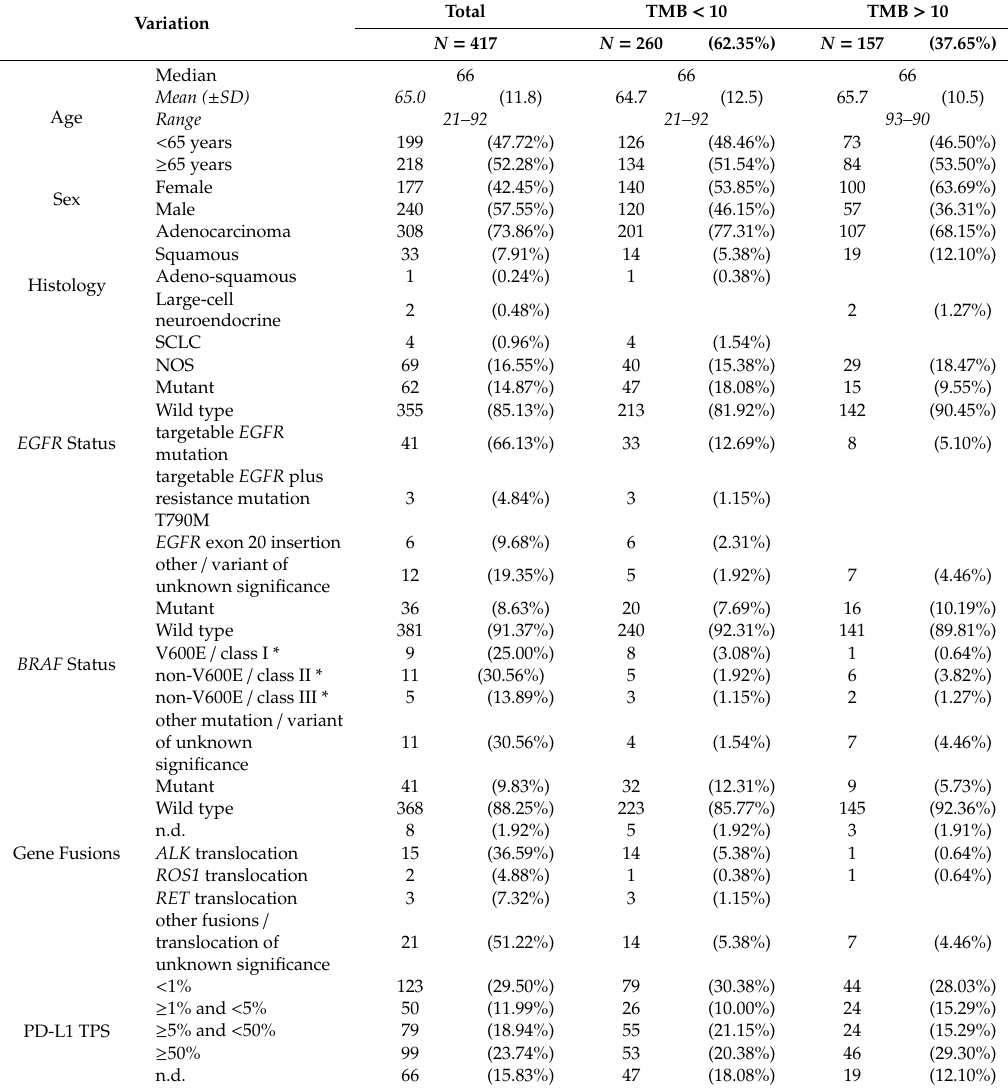
Table 1. Overview of patients’ characteristics according to TMB